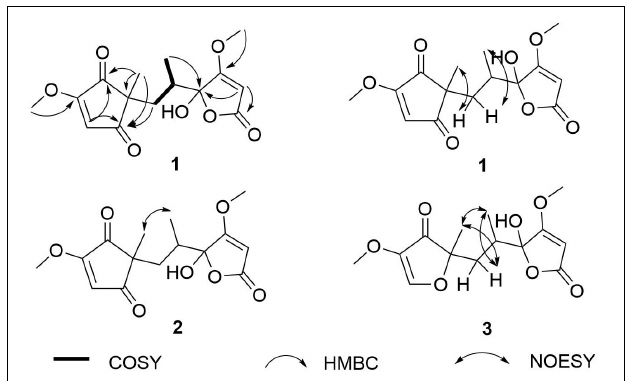
FIGURE 2 | COSY, key HMBC, and NOESY correlations of 1 – 3 .